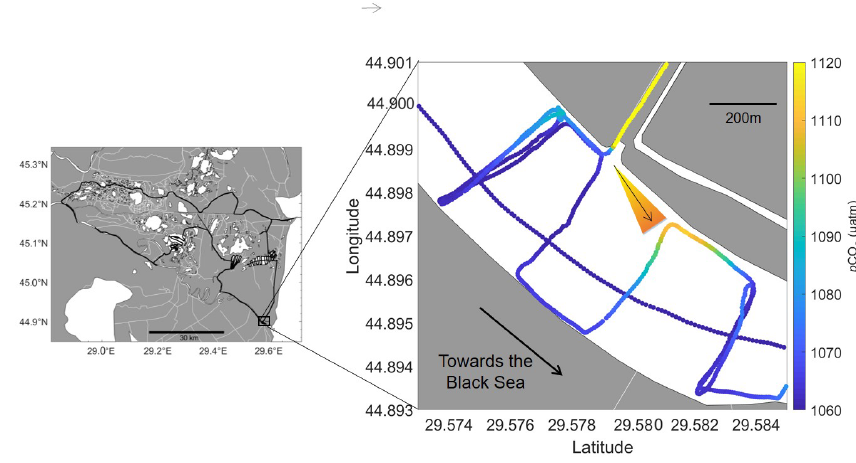
Figure 14. Small-scale spatial variability in p CO 2 (µatm) recorded in the Danube Delta from our river transects next to the entrance of a channel near St George. The direction of the water flow was visible, even with small changes in concentrations (arrow and interpretation of concentration gradient and flow direction is indicated to support the